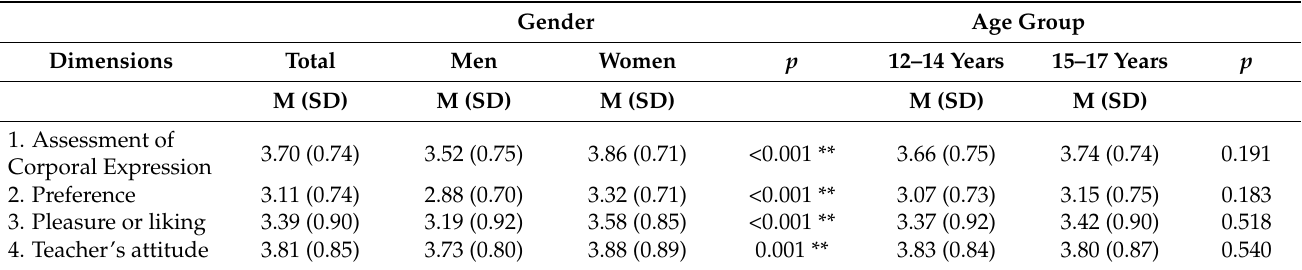
Table 3. Descriptive analysis and differences for each dimension of the instrument.